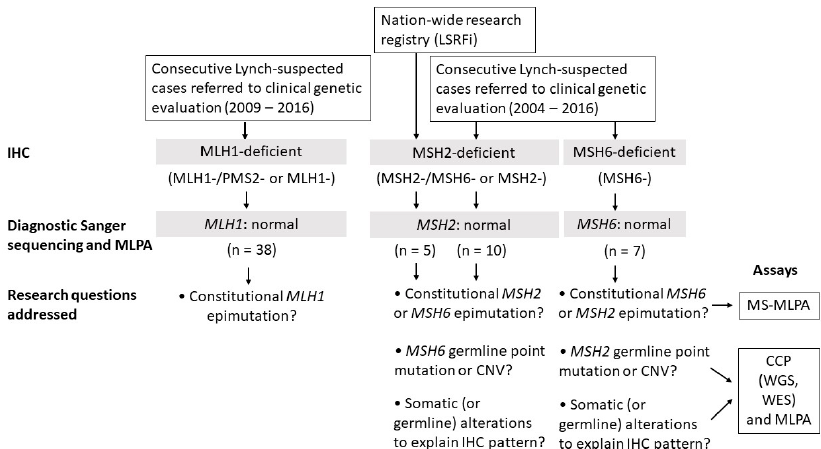
Figure 1. Flow chart of this investigation. Abbreviations: LSRFi, Hereditary Colorectal Cancer Registry of Finland; IHC, immunohistochemical; MS-MLPA, methylation-specific multiplex ligation-dependent probe amplification; CNV, copy number variant; CCP, Comprehensive Cancer Panel; WGS, genome sequencing; WES, exome sequencing.